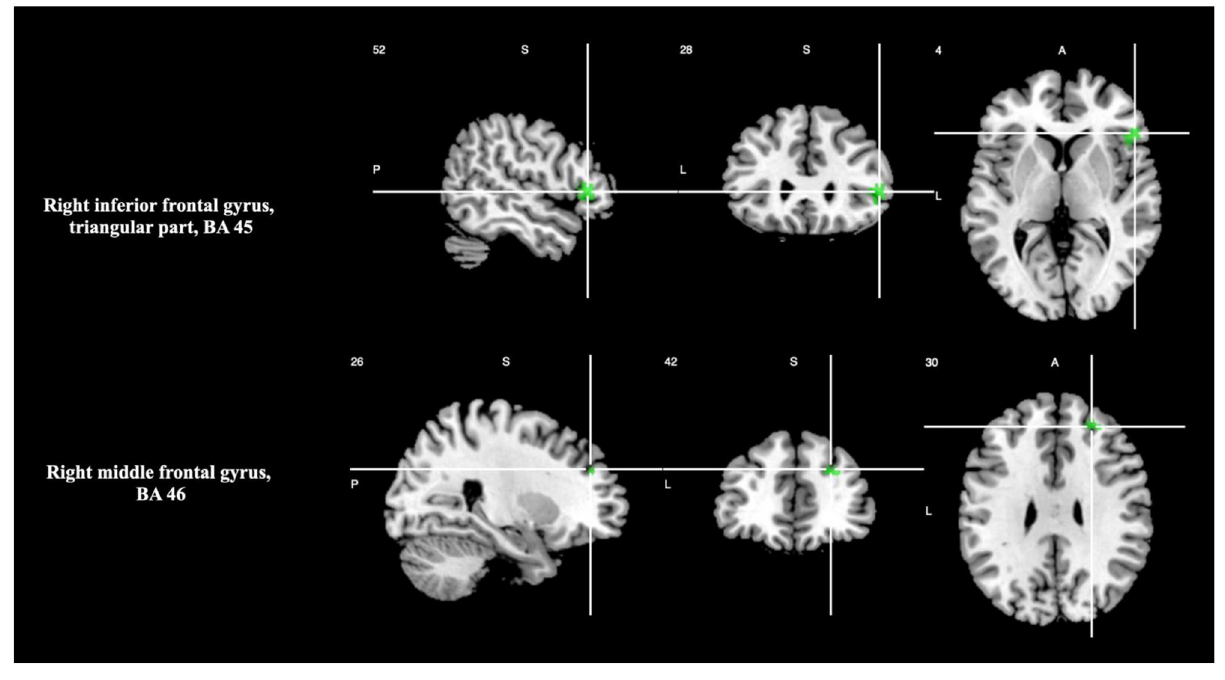
FIGURE 1 | Brain regions engaged during temporal discrimination tasks.